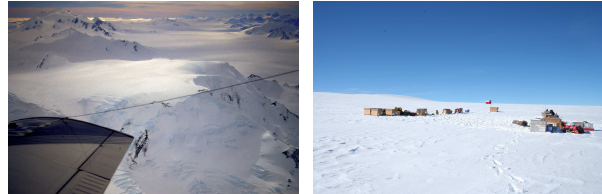
Fig. 2. Left: Photo of the northern plateau of Cordón Mariano Moreno with Volcán Lautaro in Fig. 2. Left: photo of the northern plateau of Cordón Mariano the background (photo Andrés Rivera during the reconnaissance flight on 14 April 2006). Moreno with Volcán Lautaro in the background (photo Andrés Right: Drilling site on the plateau before camp installation (photo Beat Rufibach). Rivera during the reconnaissance flight on 14 April 2006). Right: drilling site on the plateau before camp installation (photo Beat Ru-